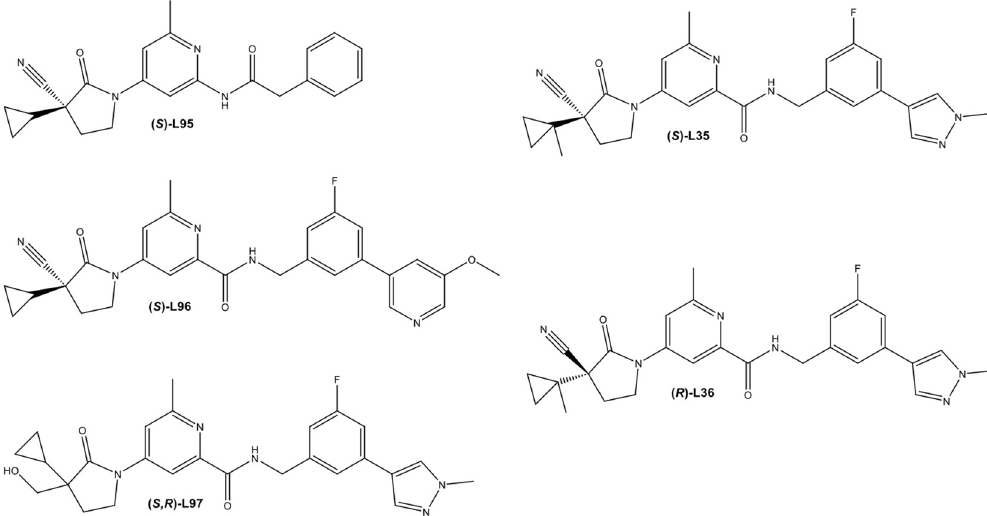
Fig 1. 2D structure. The chemical structures of the 1-(pyridin-4-yl) pyrrolidin-2-one scaffold derivatives L95, L96, L97, L35 and L36 are shown.